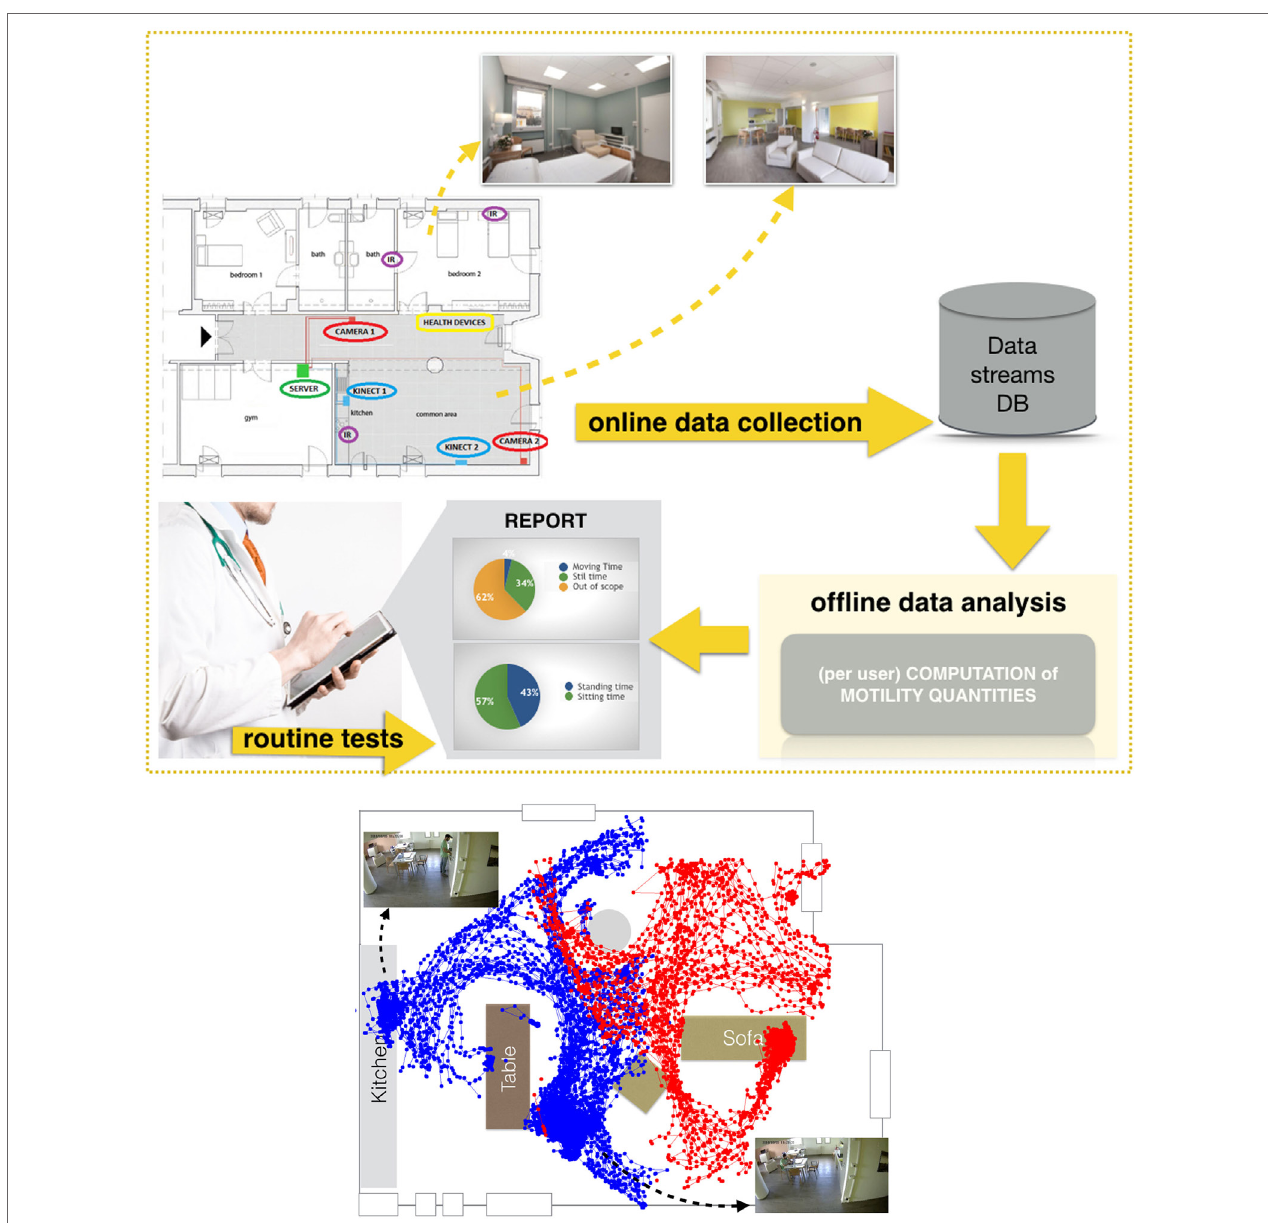
FiGUre 1 | Top: MoDiPro facility and the generated data flow. Bottom: an example of a patient localization in the main hall, with data recorded by two RGB-D sensors—color coded in red and blue, respectively. (The volunteer depicted in the figure has agreed to participate in the study and signed a written informed consent for the publication of the